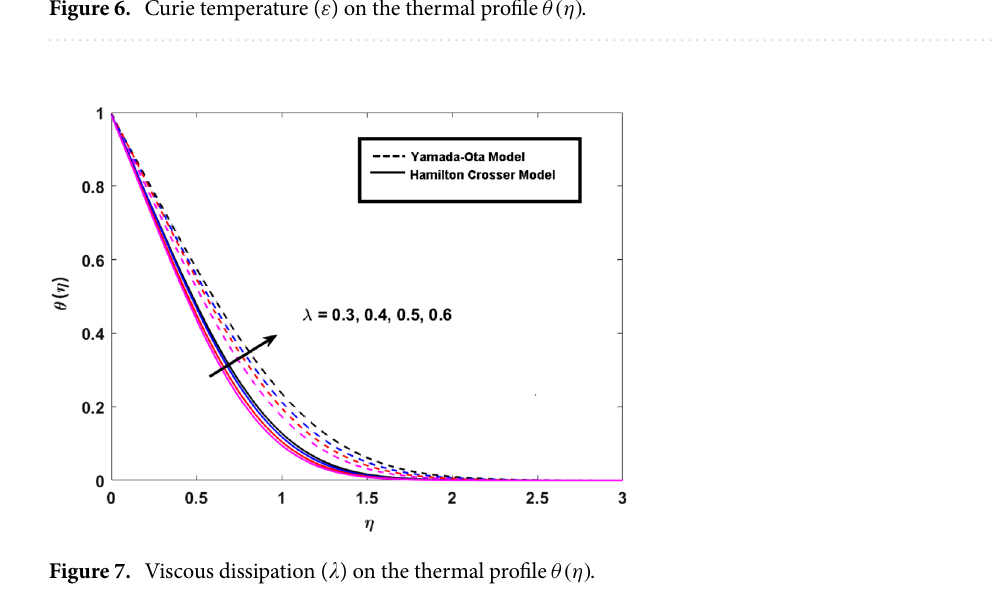
Figure 6. Curie temperature ( ε ) on the thermal profile θ(η) .